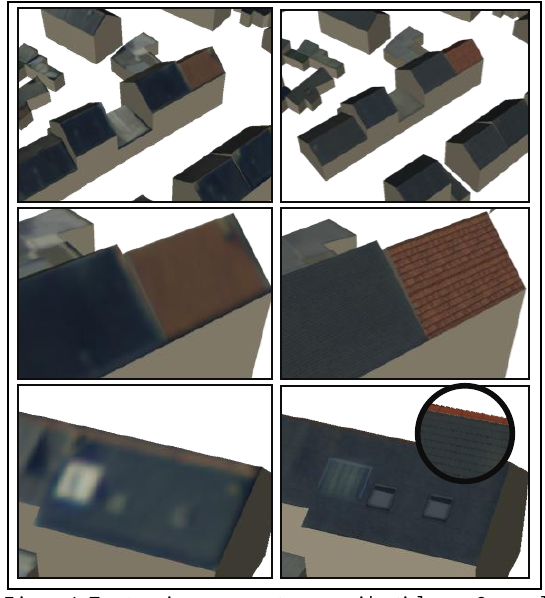
Figure 4. Texture improvement on a residential area. General view and details.